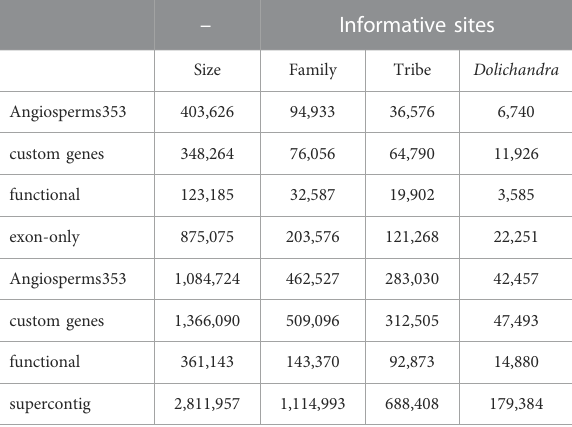
TABLE 2 Number of aligned and parsimony informative bases for each dataset in each taxonomic